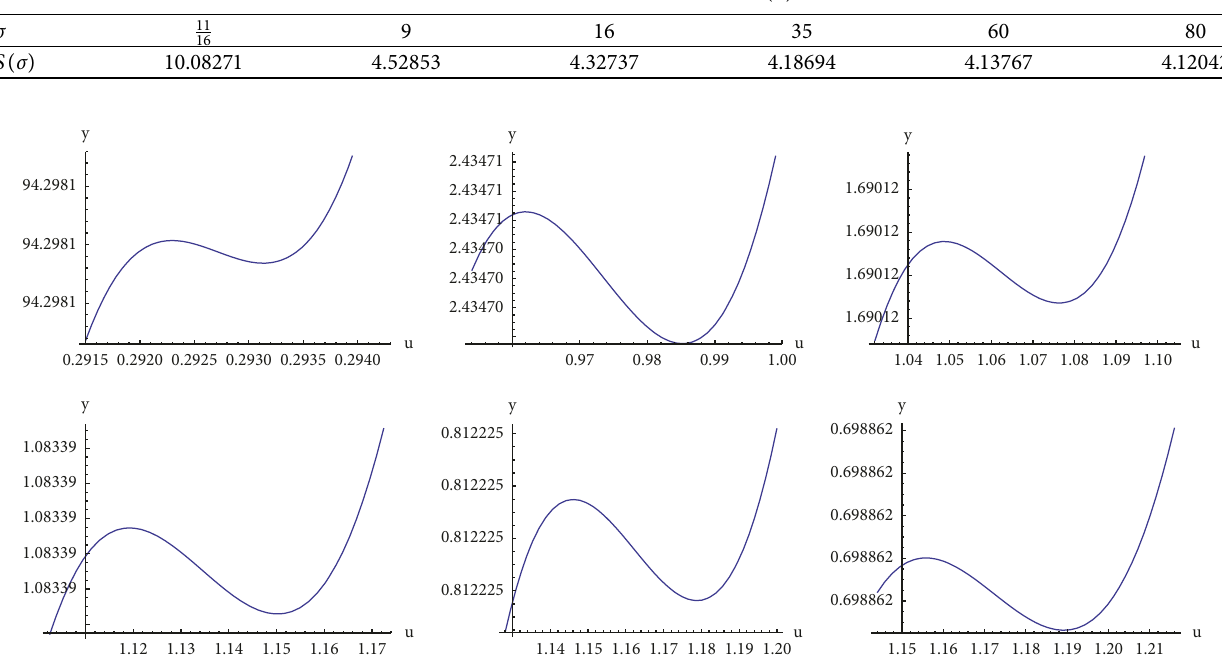
Figure 4: Graphics of H